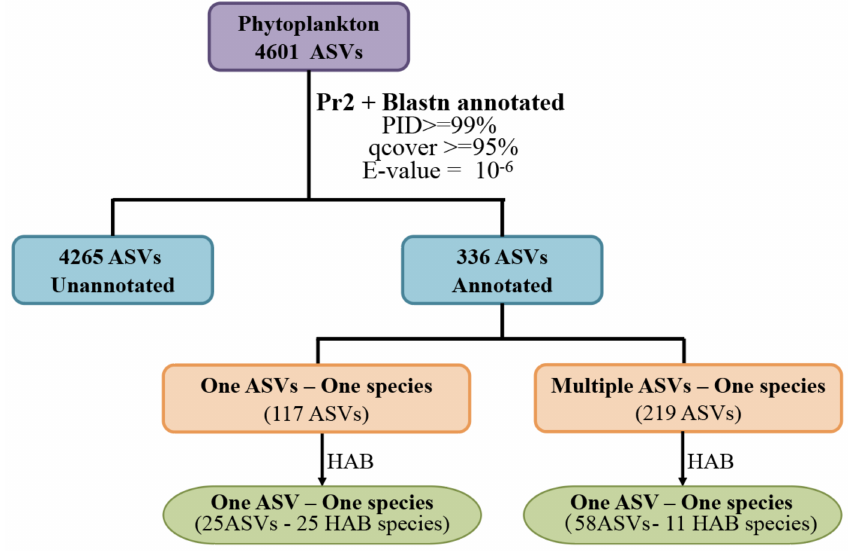
Figure 8. A flowchart describing the ASV